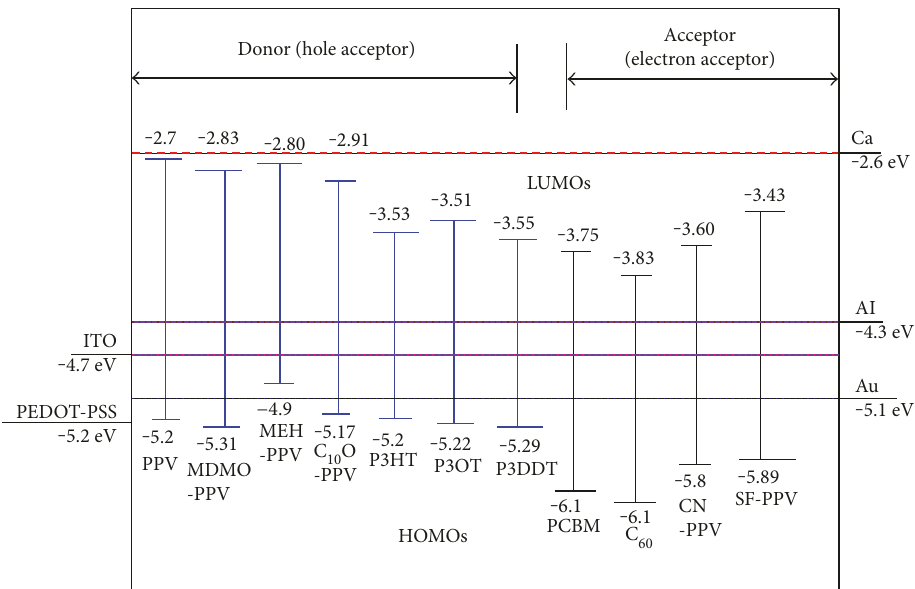
Figure 1: HOMO and LUMO energy (eV) levels of the commonly used OPV solar cell materials (source: Goswami et al., Adv. Sol. Ener., Vol. 17, Earthscan